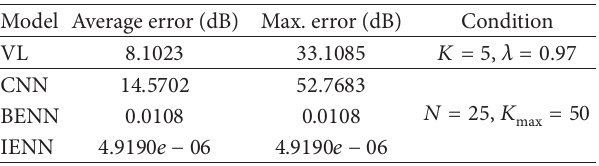
Table 6: Spectrum error of four behavioral models with 2PSK signal